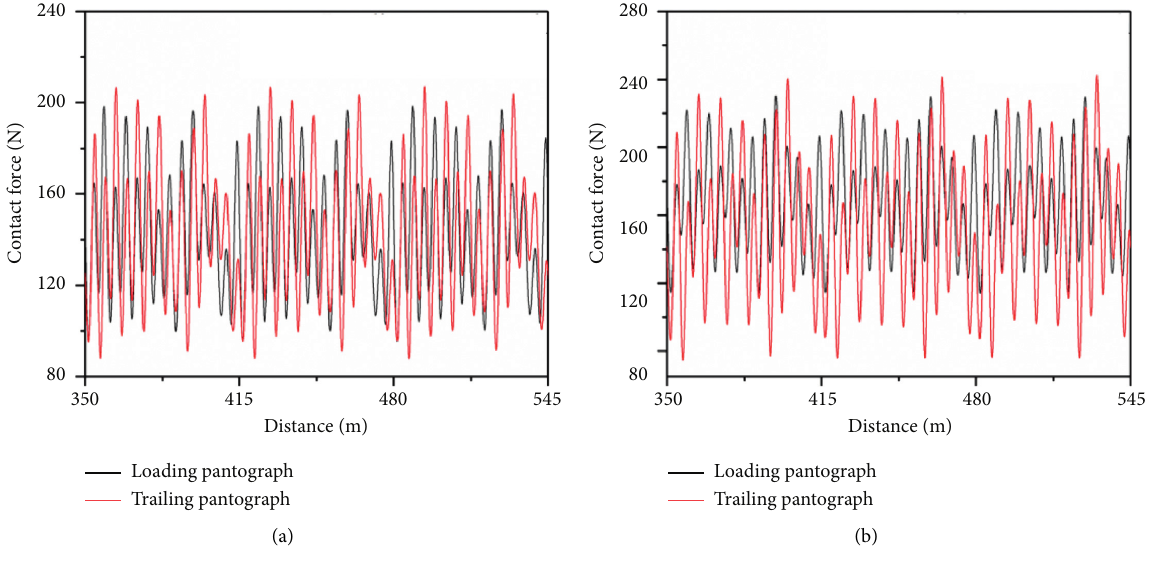
Figure 3: Contact force of reference model in EN50318-2018:(a) 275km/h (b) Table 3: Validation of the PAC model from reference model of EN50318-2018. Simulation results